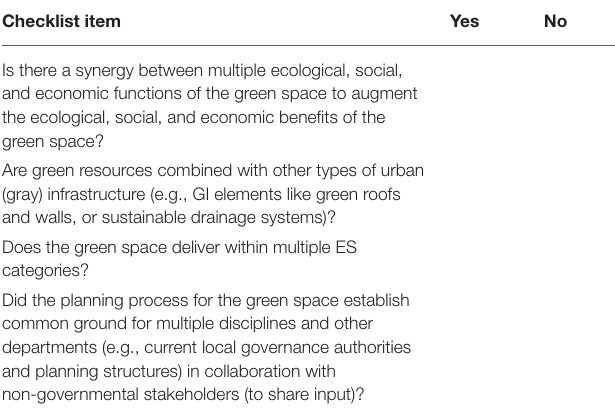
TABLE 4 | Checklist to evaluate GI elements. Checklist item Yes No Is there a synergy between multiple ecological, social, and economic functions of the green space to augment the ecological, social, and economic benefits of the green space? Are green resources combined with other types of urban (gray) infrastructure (e.g., GI elements like green roofs and walls, or sustainable drainage